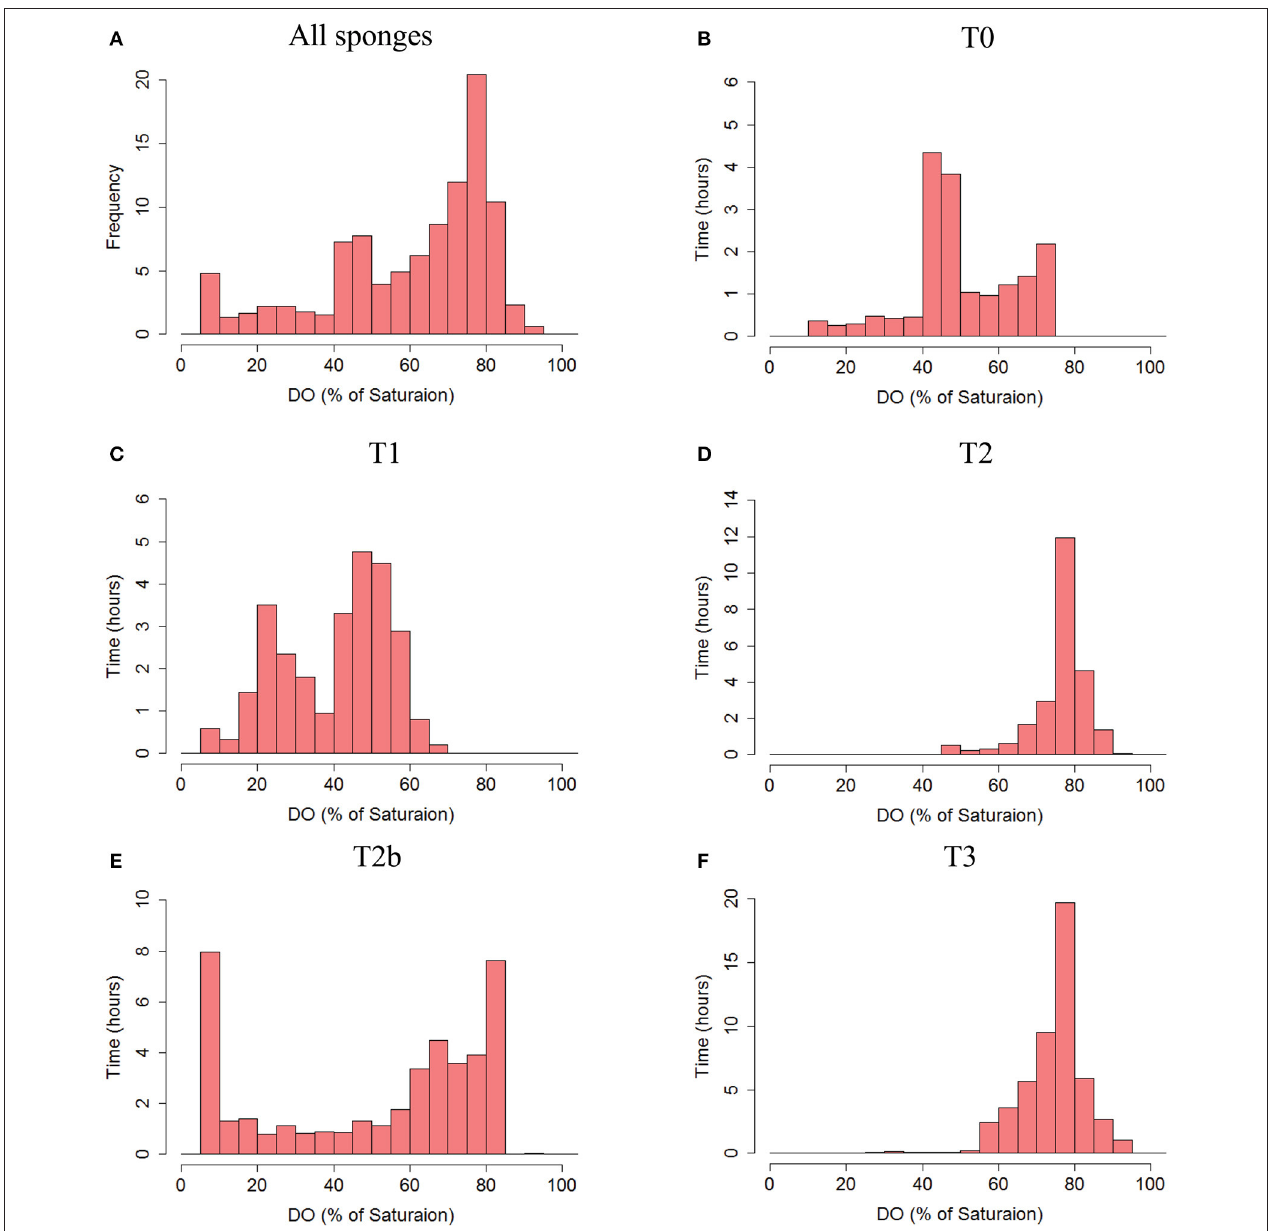
FIGURE 4 | Frequency distribution of the DO saturation (%, 30s averages) in the tissue of the sponges. (A) The total frequency of DO % of saturation from all sponges pooled together. (B) T0, (C) T1, (D) T2, (E) T2b, and (F) T3. Co-occurrence of DO saturation in osculum and tissue of each sponge is given in Figure